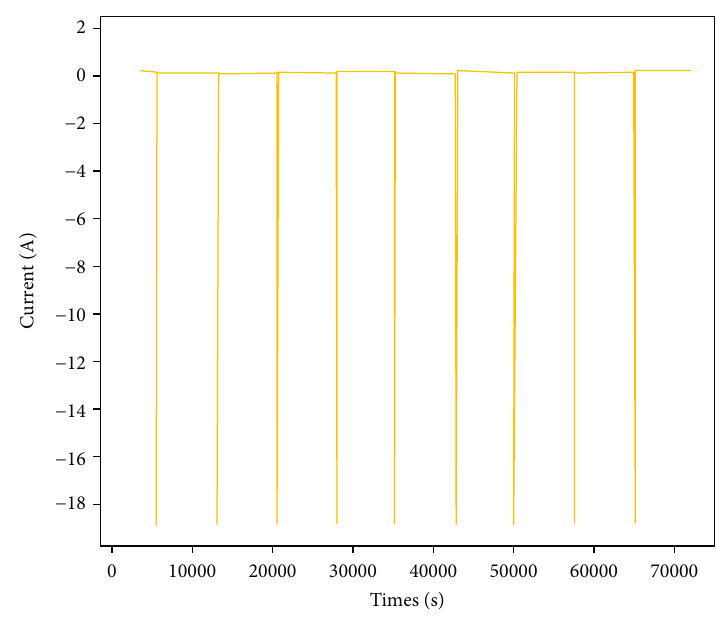
Figure 7: Input current